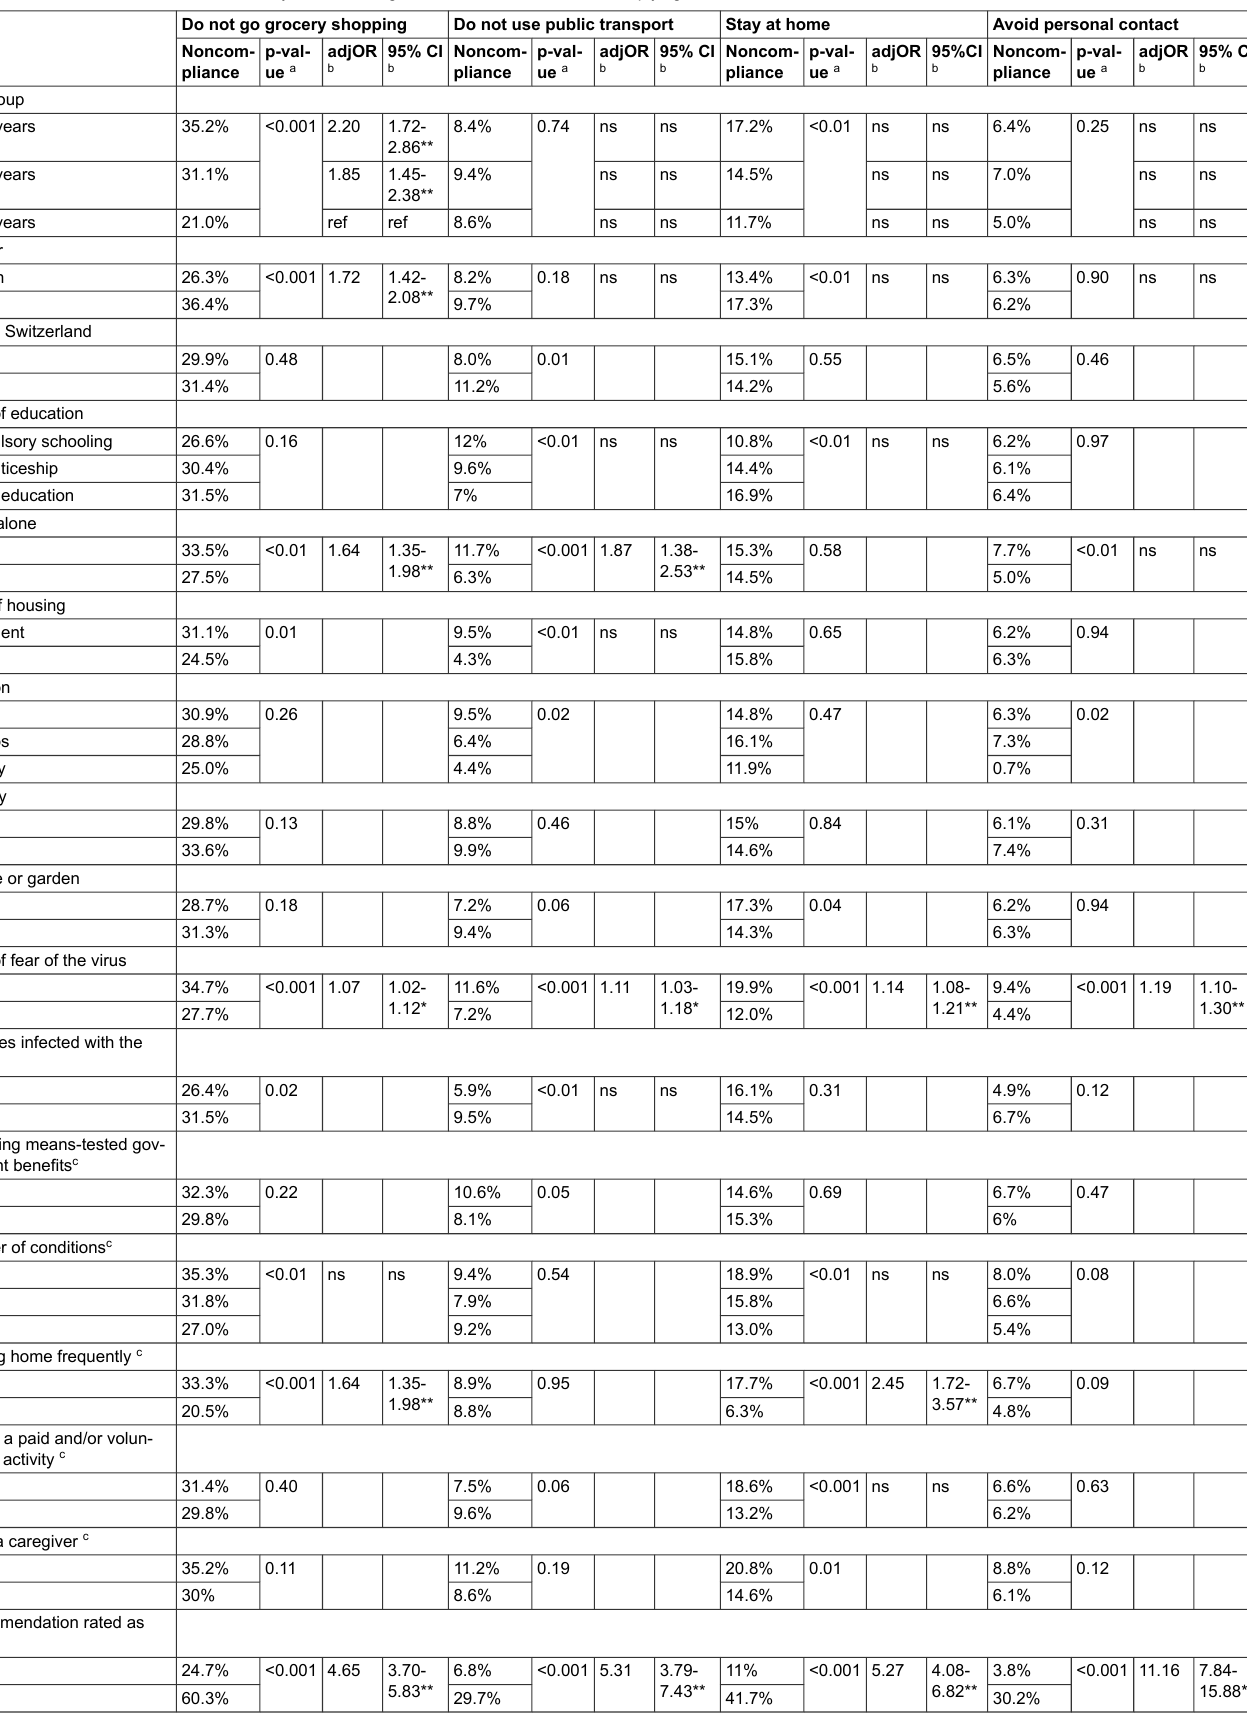
Table 5: Results from bivariable and multivariable analyses examining factors associated with not complying with the recommendations. Do not go grocery